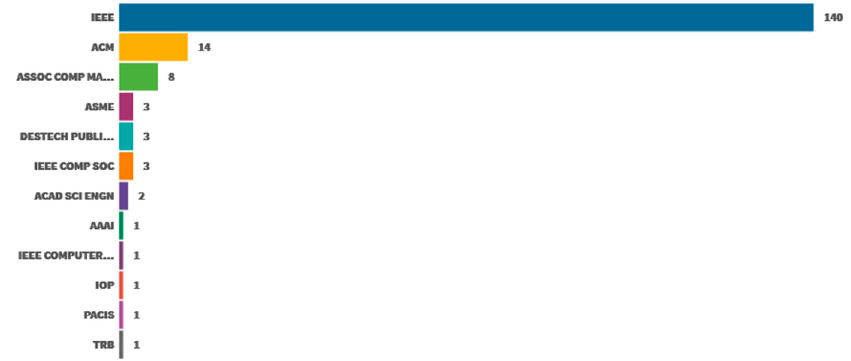
Figure 4. Group Authors and Record Count (669 records (79.172%) do not contain data in the field being analyzed).